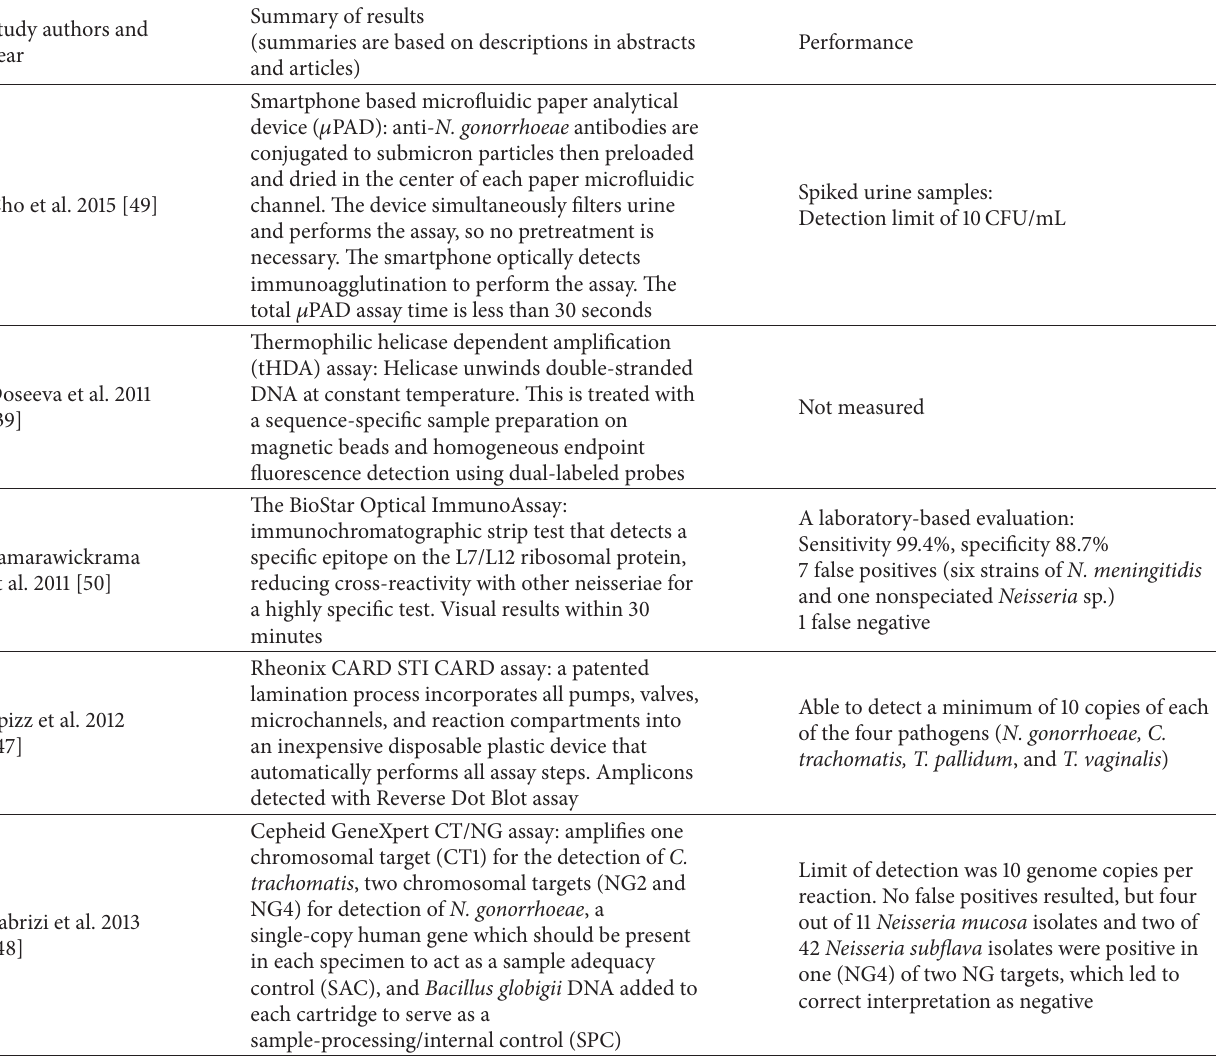
Table 5: Summary of proof of concept articles on point of care tests for Neisseria gonorrhoeae from 2010 to 2015. Study authors and